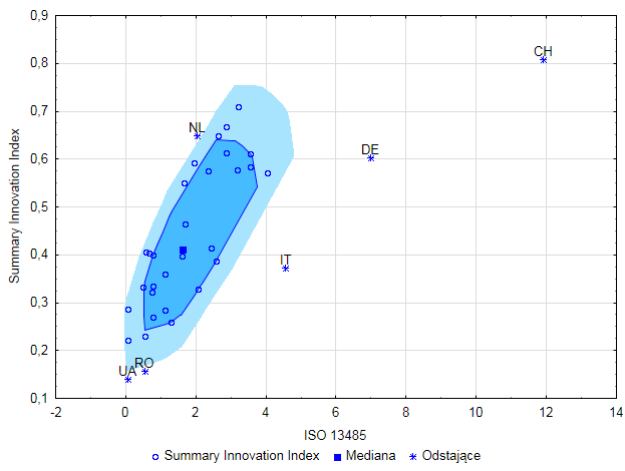
Figure 2. Bagplot between ISO 13485 and SII Table 3. Correlation between the SII and innovation dimensions